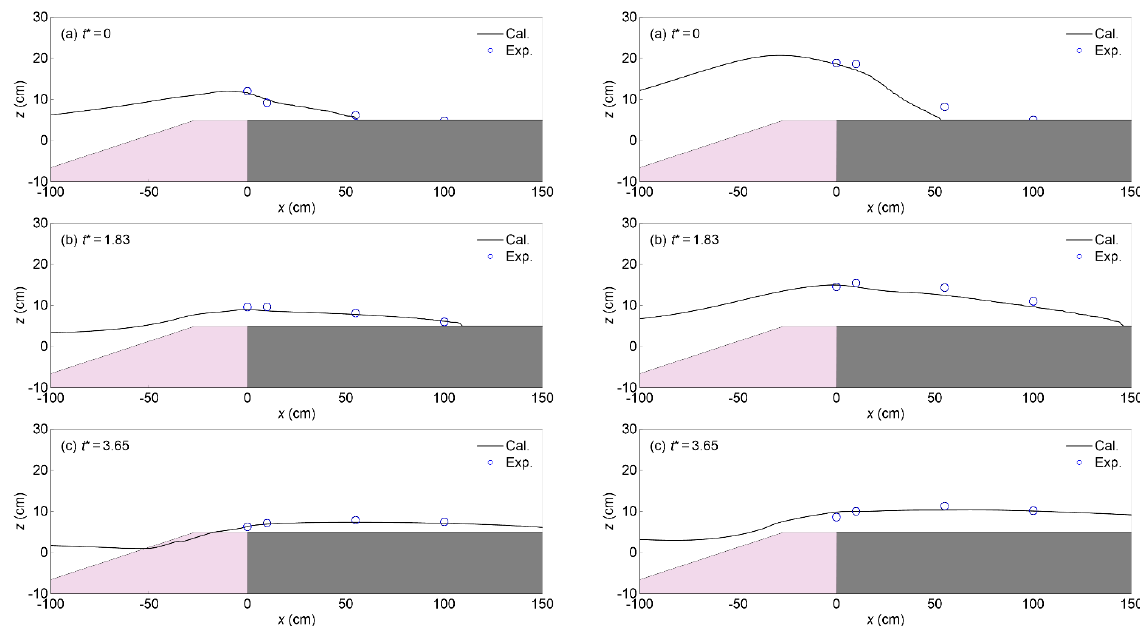
Figure 13. Spatial distributions of measured and calculated water surface elevations around the WAR (left: Run-4 ( A 0 = 8.2 cm, ε = 0.18), right: Run-10 ( A 0 = 18.7 cm, ε = 0.4))—comparison between the measured and calculated results.